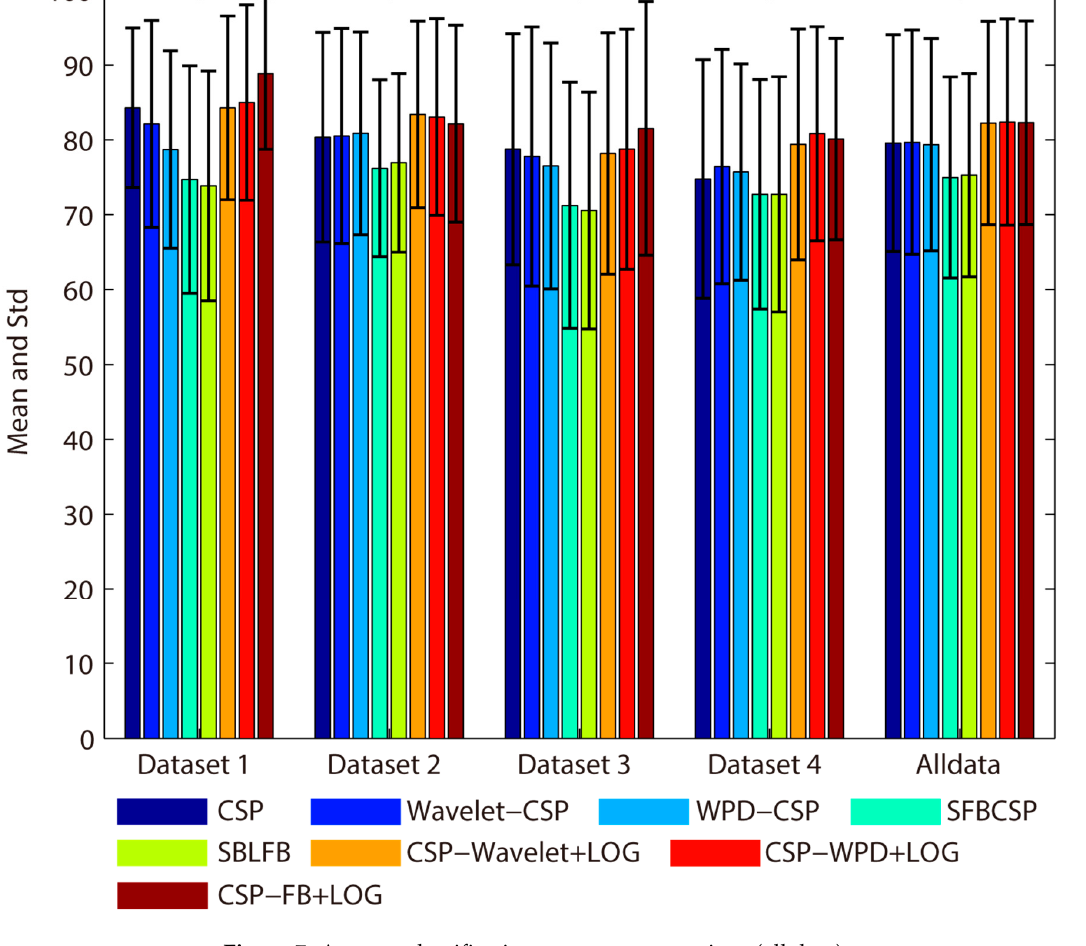
82.06 Table 7. The effect of secondary feature selection on average classification accuracy of various datasets (the LOG method). Datasets